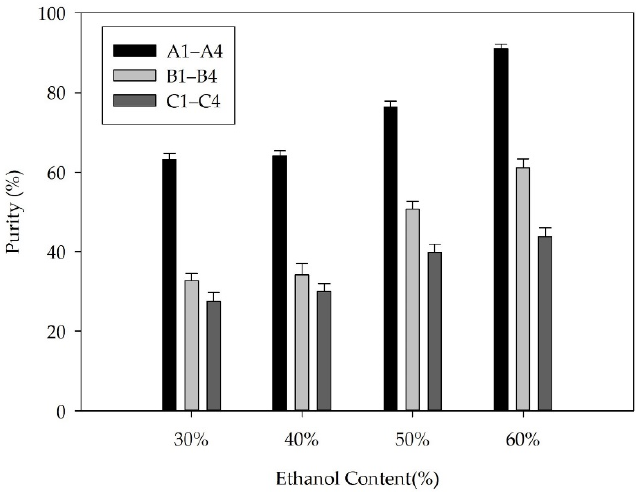
Figure 5. The FX concentration ( a ) and volume ( b ) of the solutions A1–A4, B1–B4, and C1–C4.